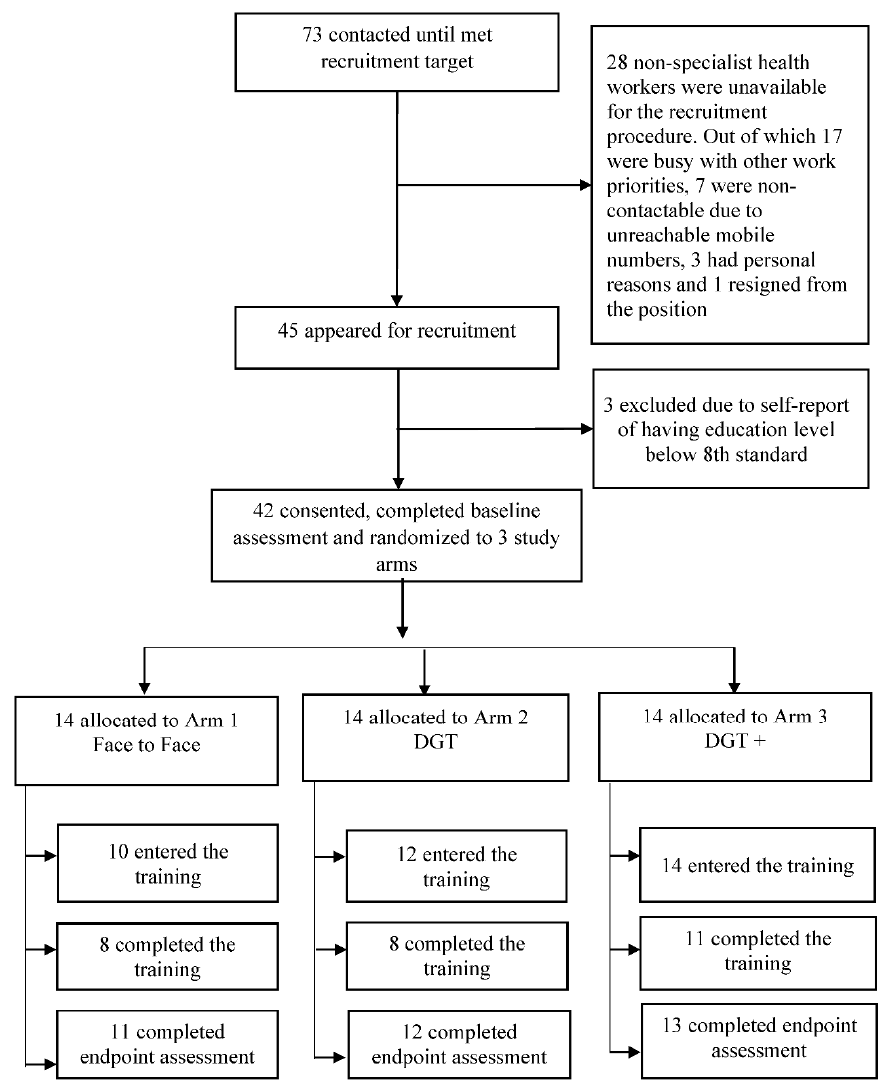
Figure 1. Participant flow diagram. DGT: Digital Training.